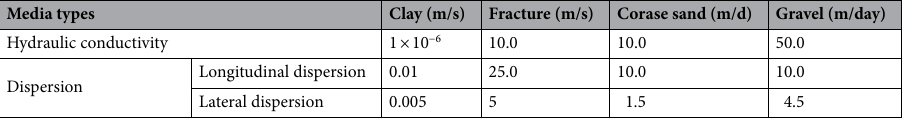
Table 4. Parameter inversion